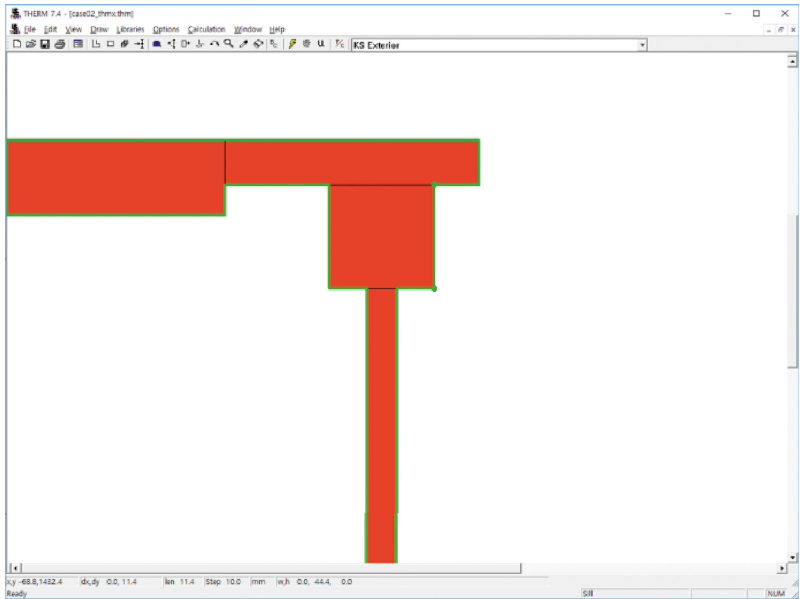
Figure 11: THERM input result of test case 1.